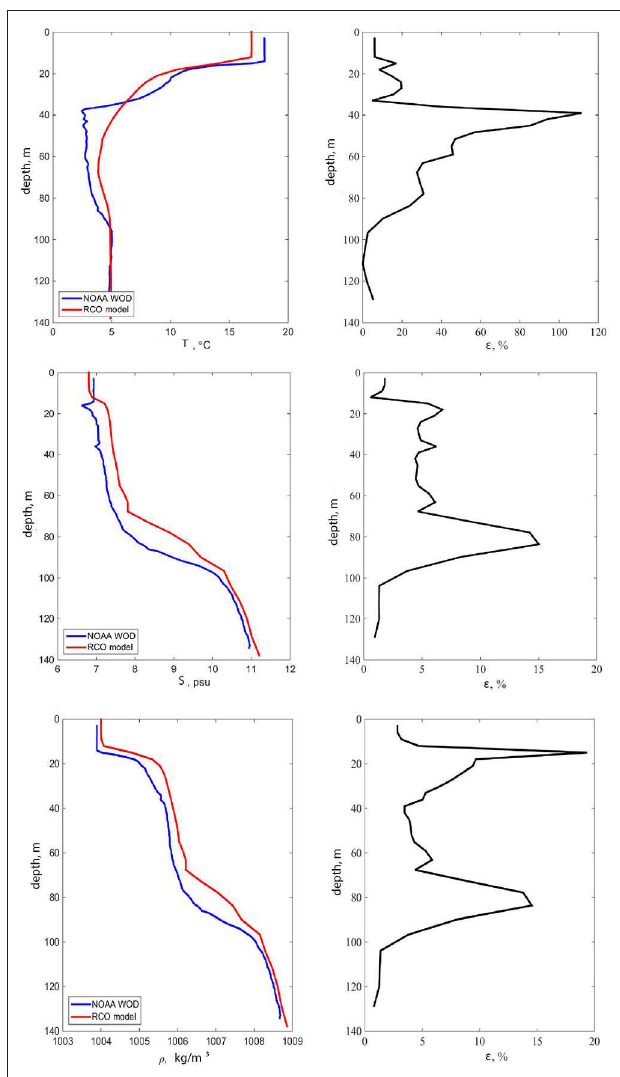
FIGURE 2 | Temperature ( T ), salinity ( S ) and density ( ρ ) profiles from the World Ocean Database and from the RCO model, and the associated relative error ( ε ) at the location with coordinates 20.583 ◦ E, 57.525 ◦ N on August 28, 1994.